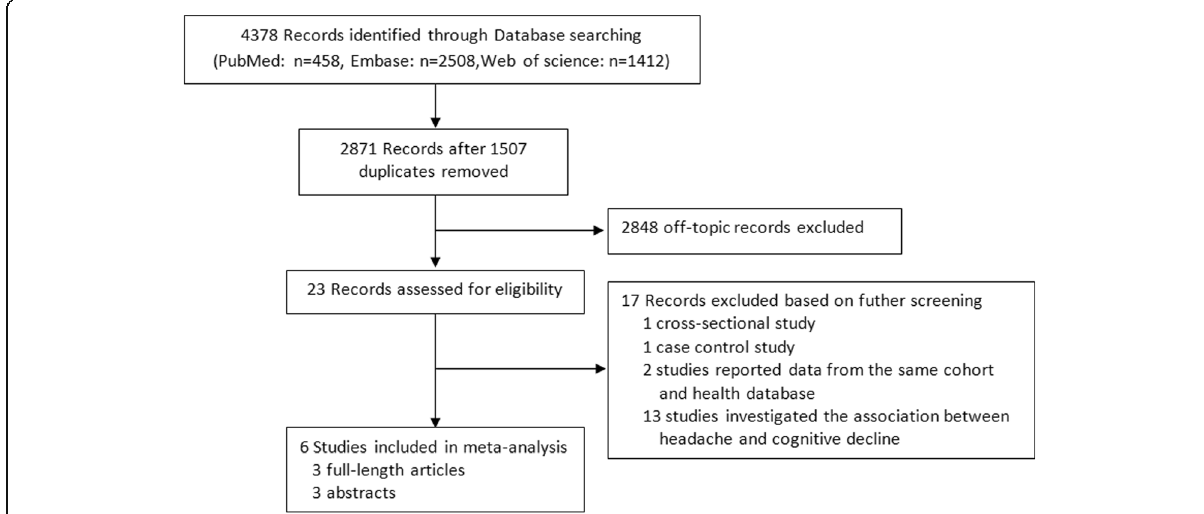
Fig. 1 Flowchart of study identification for meta-analysis